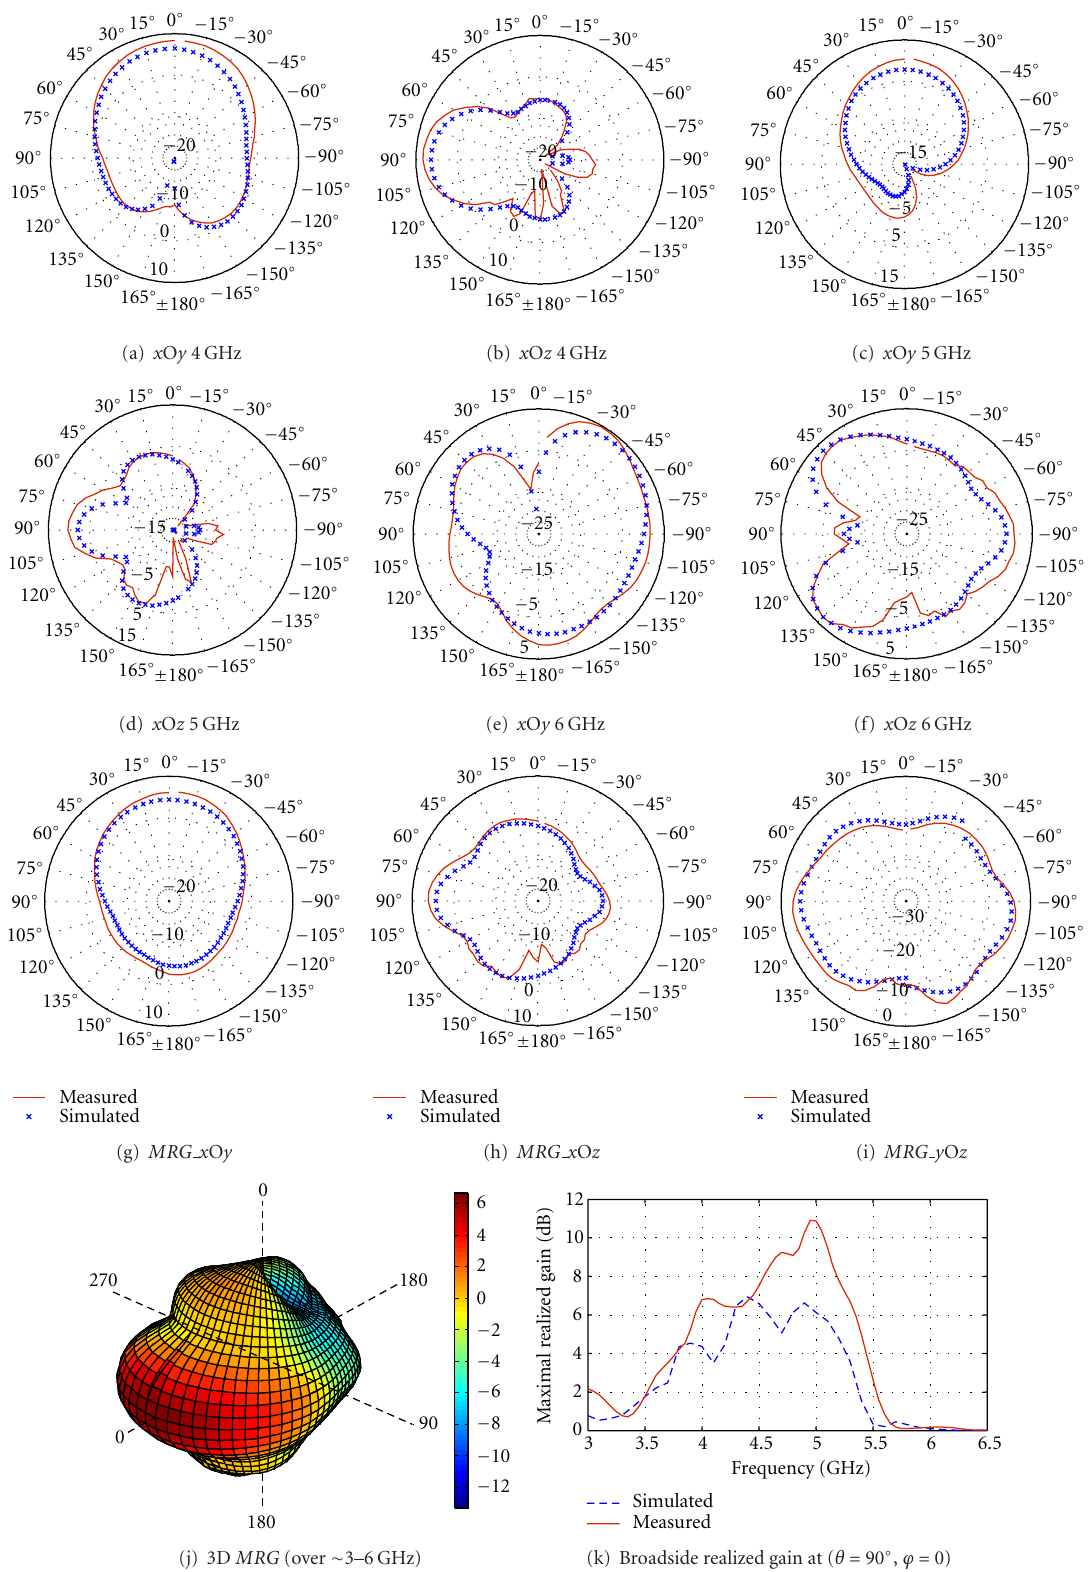
Figure 12: (a)–(f) Measured and simulated realized gain patterns of the MSA-BP in two principle planes (azimuth and normal elevation), (g)–(j) measured and simulated mean realized gain (2D) in three plane cuts and a 3D mean realized gain pattern, (k) broadside realized gain at ( θ = 90 ◦ , ϕ =